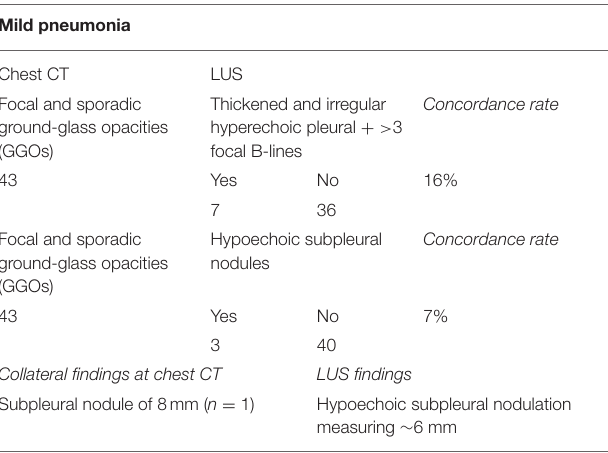
TABLE 3 | Concordance rate between LUS and CT in patients with initial mild CT scan findings. Mild